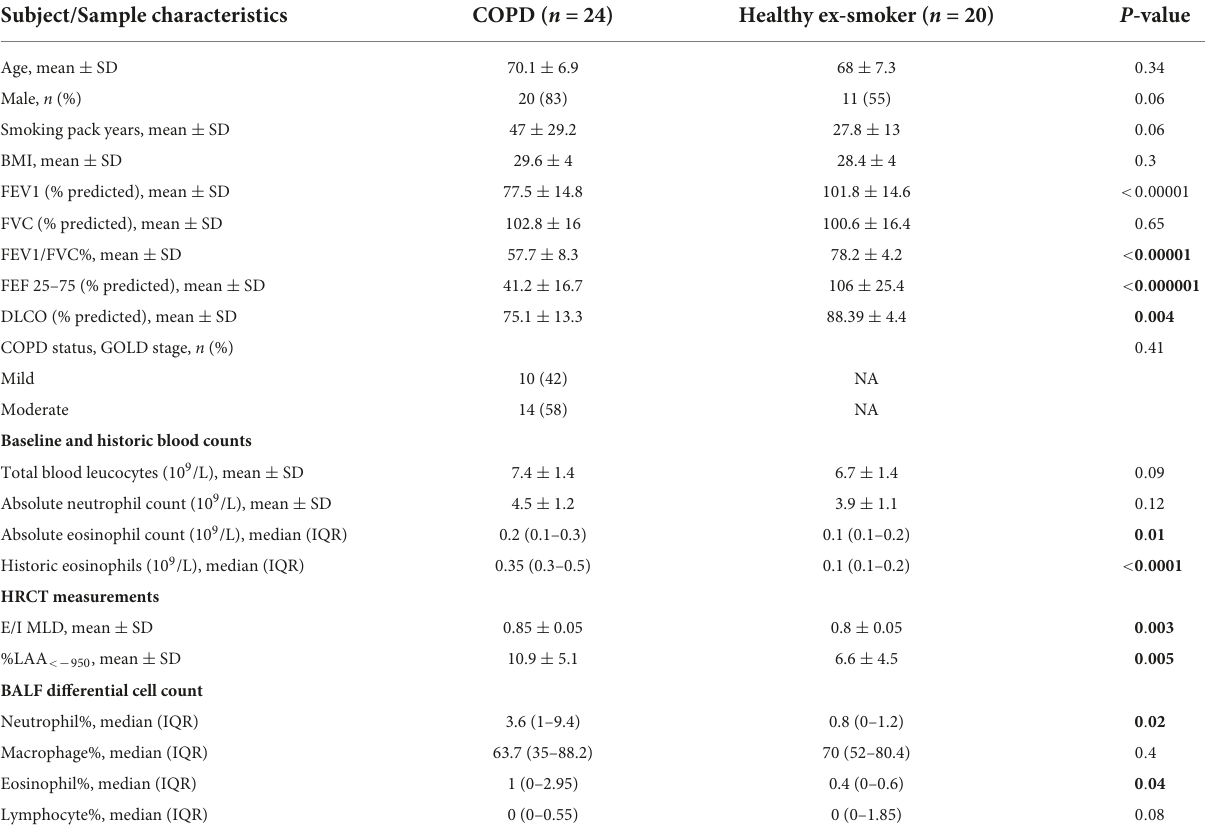
TABLE 1 Characteristics of subjects included in the analysis exploring the diagnostic use of bronchoalveolar lavage (BALF) extracellular vesicle (EV) microRNA (miRNA) and associations with inflammatory endotypes, N = 44.